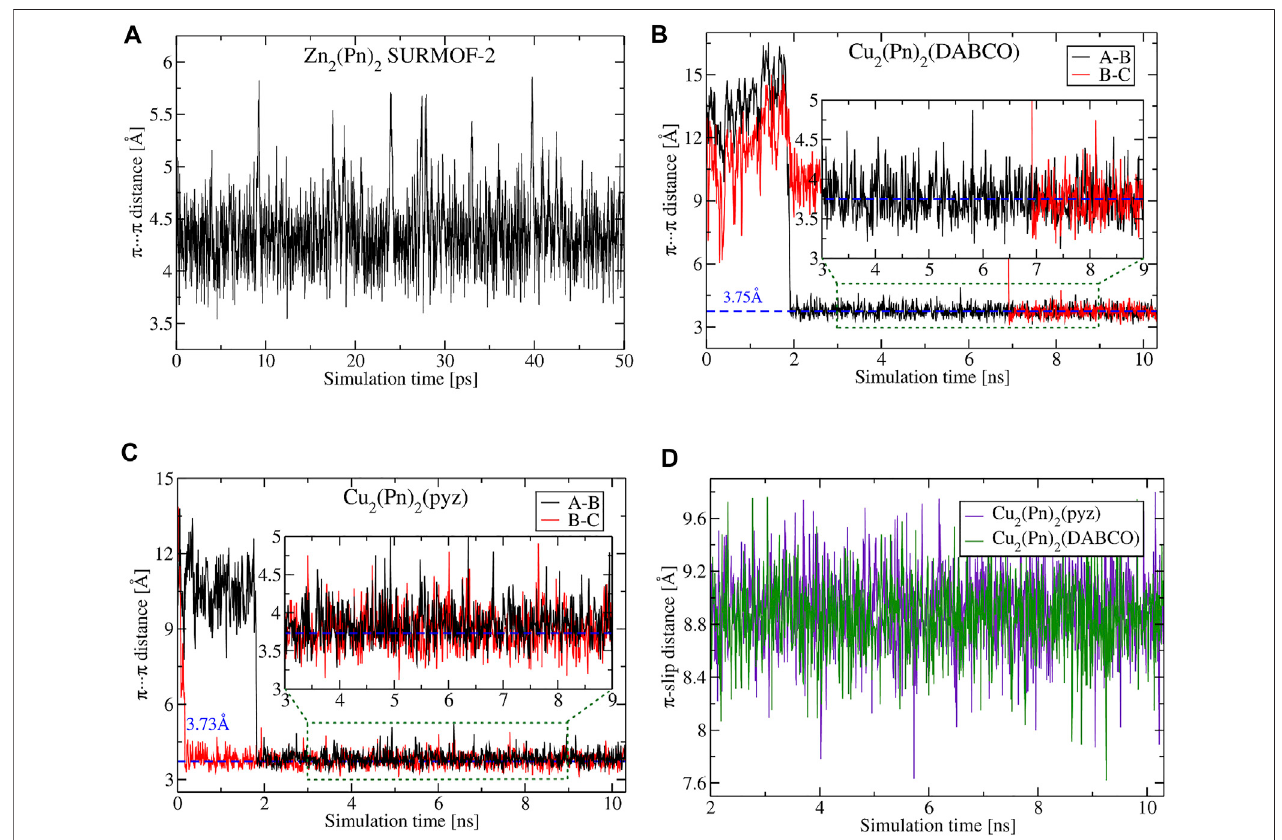
FIGURE 8 | Dynamical change of π – π interaction and π -slip distances between pentacene cores in MOF materials of different topologies and COM distances obtained fromMD simulations at room temperature.The π – π distance inadimer from SURMOF-2reportedbyHaldar et al.(2021) (A) ,inadimer from Cu 2 (Pn) 2 (DABCO) (B) and Cu 2 (Pn) 2 (pyz) (C) . The comparison of π -slip distances between layer linkers in Cu 2 (Pn) 2 (DABCO) and Cu 2 (Pn) 2 (pyz) (D) . Plotted structural parameters and “ A ” -, “ B ” -, “ C ” -marked linkers are depicted in Figure 7 .